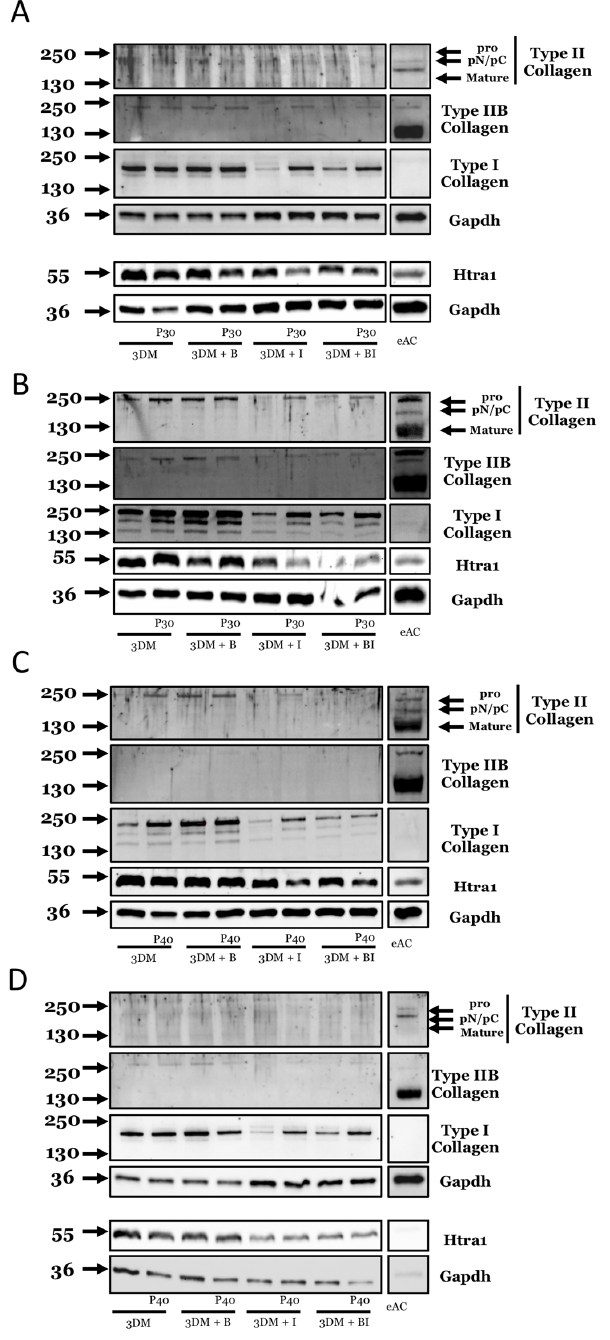
Figure 13. Effect of low concentrations of Promerim ® on chondrocyte protein expression of types II and I collagens and Htra1. Equine articular chondrocytes (eACs) at P3 were inoculated in collagen sponges with different treatments: 3D control culture medium (3DM), B (BMP-2), I (IL-1), B + I (BMP-2 + IL-1), P30 (Promerim ® 30), P40 (Promerim ® 40). ( A ) P30 at 0.1 µg/mL; ( B ) P30 at 0.5 µg/mL; ( C ) P40 at 0.1 µg/mL; ( D ) P40 at 0.5 µg/mL. Protein expression of equine articular chondrocytes was evaluated after 7 days of 3D culture in the presence and absence of treatment. The total protein extracts were separated by electrophoresis in 10% acrylamide gel in denaturing condition. The molecular weights expressed in kDa are shown on the left part of the panels and the antibodies used on the right part of the panels. Representative blots from different eAC strains are shown (at least n = 3). eAC: protein extracts obtained from equine articular cartilage are used as controls.